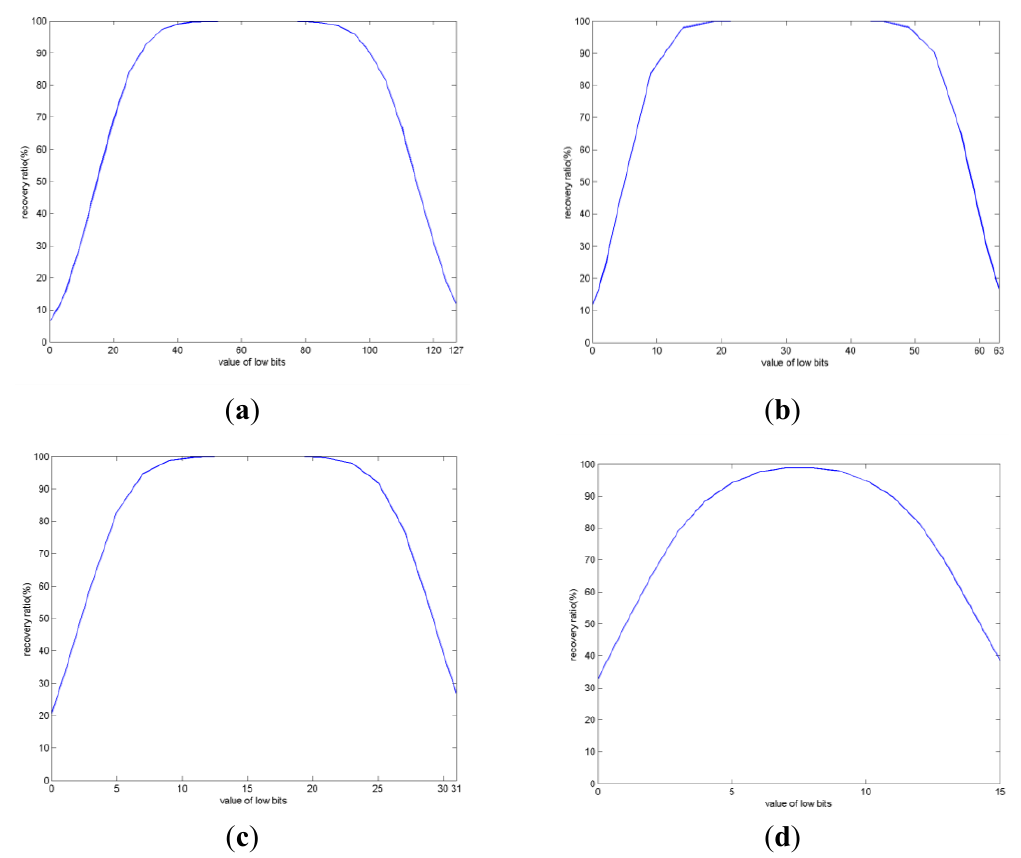
Figure 4. Recovery accuracies of the secret text with different methods being used to fill the lower bits of the elements in the transformed array A . The host image is Lena ( a ) m =